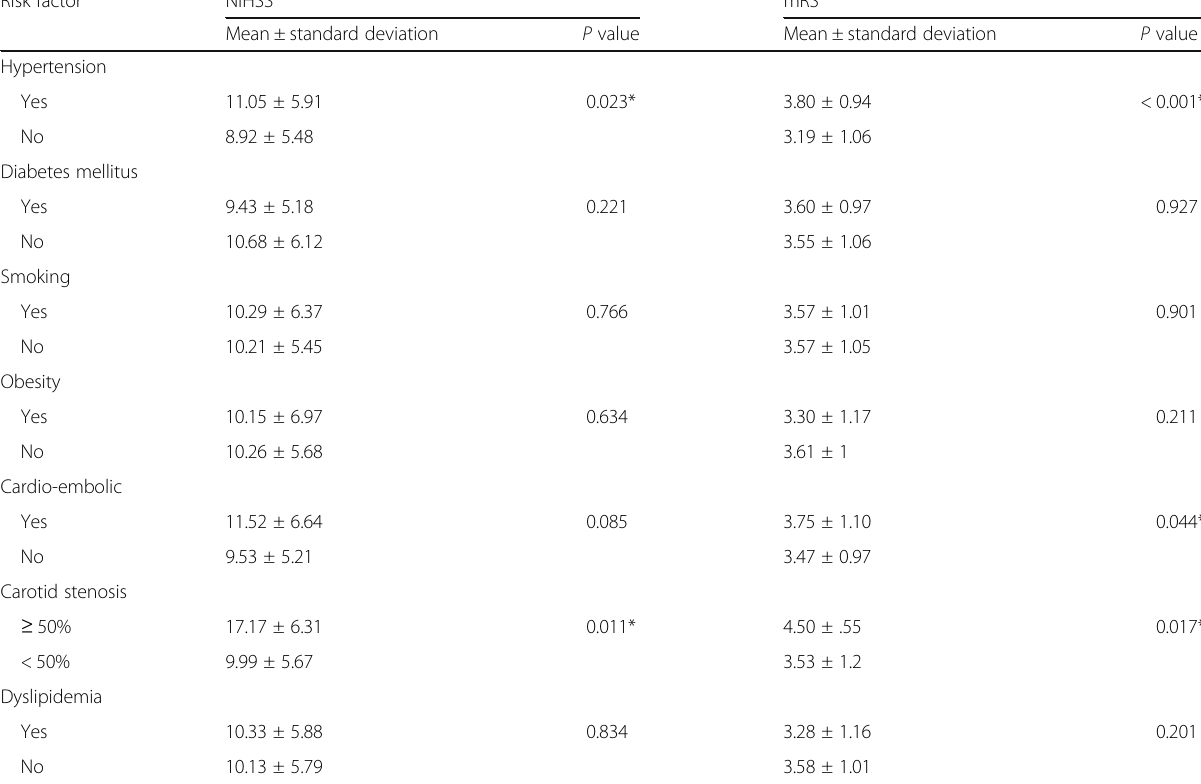
Table 6 Relation between modifiable risk factors and ischemic stroke severity and disability at presentation using NIHSS and